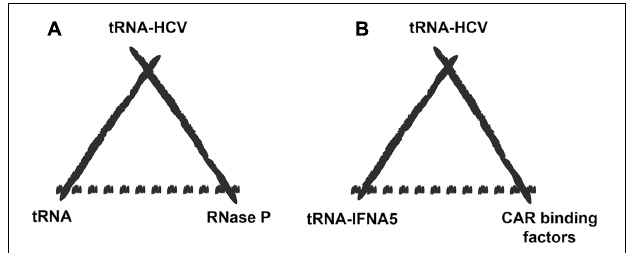
FIGURE 2 | Extended biosemiotic relationships of tRNA mimics. (A) A particular example of tRNA mimicry would be the case of hepatitis C virus mRNA carrying a tRNA mimic element (representamen) that is specifically recognized by RNase P (the interpretant), which normally processes the tRNA precursor molecule (the model). (B) Potential switch in the tRNA mimetic relationship after the discovery of a tRNA-mimicking element in IFNA5 mRNA. The model for the viral RNA to mimic could now be a cellular mRNA rather than the tRNA molecule itself (in this case the mRNA for liver IFNA5). The deceived interpreter would be those factors that naturally interact with the IFNA5 mRNA-tRNA-mimicking region, such as CAR binding